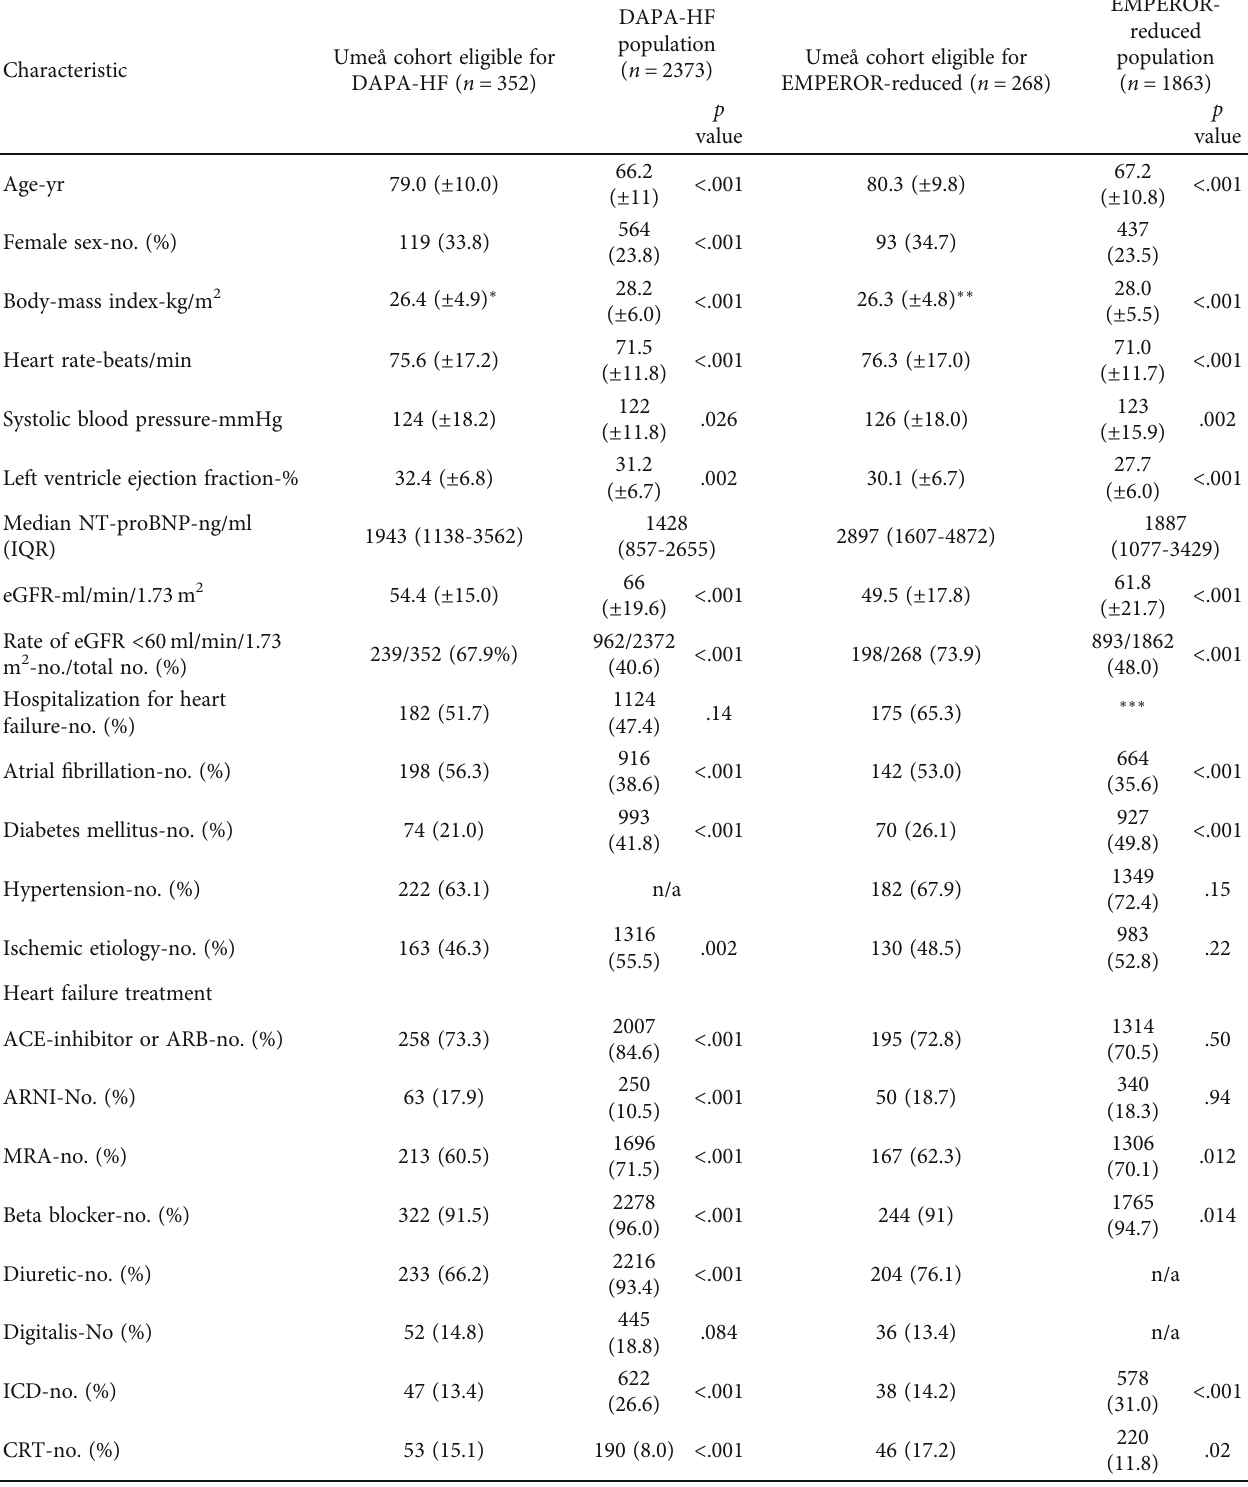
Table 1: Comparison of eligible patients for DAPA-HF and EMPEROR-reduced, compared to patients receiving trial drug in respective